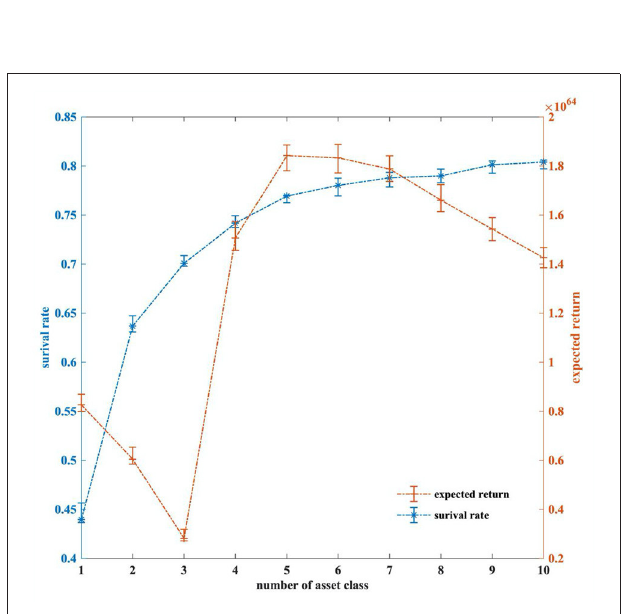
FIGURE 7 | The expected return of the bank under different values of θ with various the asset-liability ratios.